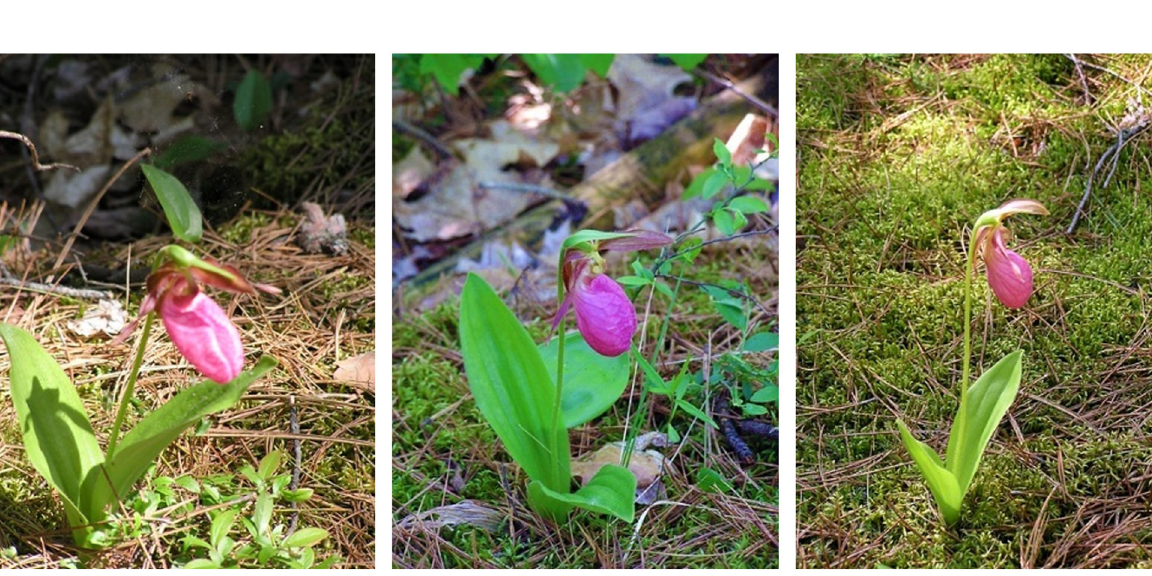
Fig 13. The color of the orchids seen in the pictures (purple) corresponds to the literature, whereas the classifier predicted white as their color.